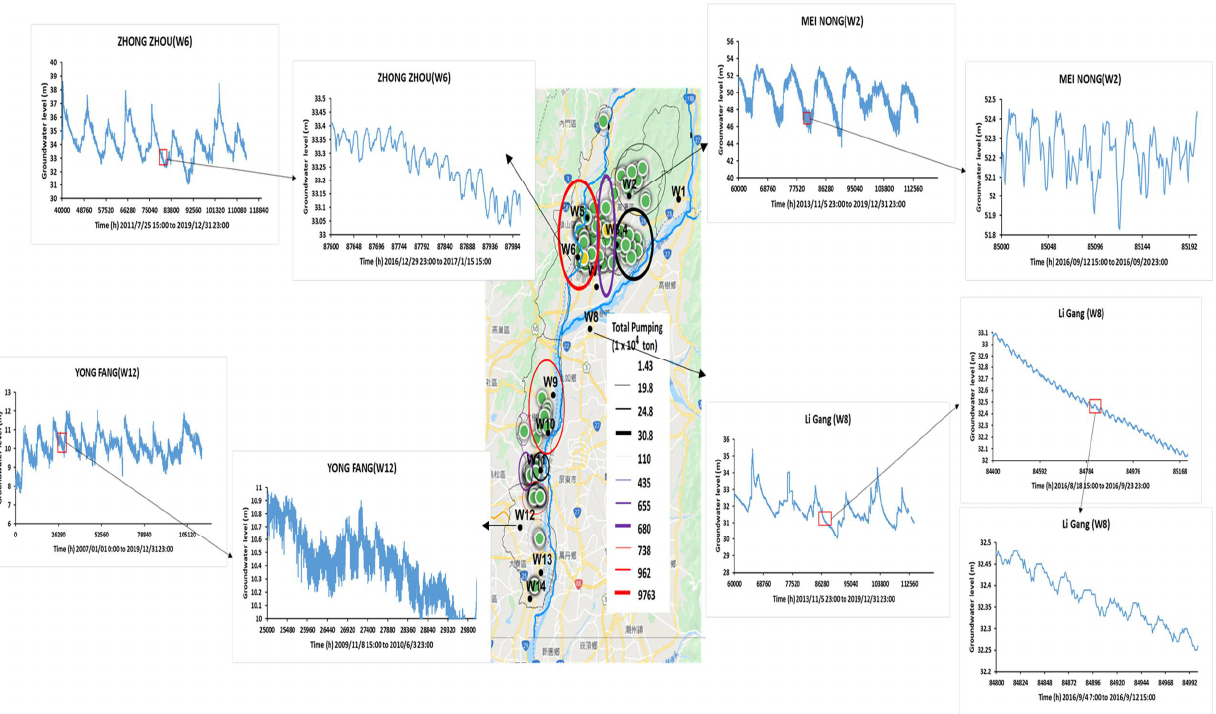
Figure 10. Effects of pumping and change in pressure head on groundwater level fluctuations in unconfined and confined aquifers. It was analyzed that observation wells Yong Fang (W12) and Zhao Ming (W14) are producing natural fluctuation due to pressure head change from unconfined to confined aquifer because fluctuations are irregular in size and arrangement. The pumping effect only can be observed at Mei Nong (W2) site where pumping produces the top smooth line and drop-in level from that line. Generally, when talking about Jiu Qu (W11), the patterns are mixed with pumping and pressure head difference but pumping effects are more as compared to pressure head variation from unconfined to confined. This pumping and non-pumping scenario harvest a typical pattern of groundwater hydrograph that differs significantly from natural fluctuation due to pressure head change. Thus, the nature of the aquifer (confined or unconfined) can be predicted based on the apparent line thickness of the groundwater hydrograph.